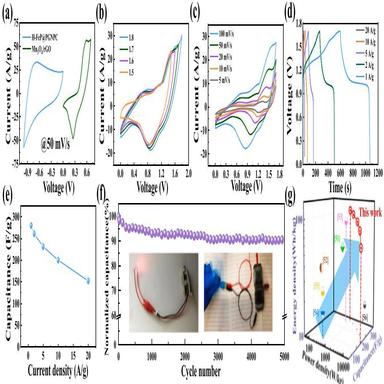
a) CV curves of the Mn3O4-rGO and H-FeP@PGNPC at the scan rates of 50 mV s −1. b) CV curves of the Mn3O4-rGO//FeP@PGNPC ASC at different voltage window. c) CV curves of the Mn3O4-rGO//FeP@PGNPC ASC at different scan rates. d) GCD curves of the ASC at different current densities. e) specific capacitances of the ASC. f) cycling stability of the Mn3O4-rGO//FeP@PGNPC ASC, and the inset in (e) presenting the two ASC configurations connected in series to power LEDs and an USB electric fan. g) The Ragone plot rela